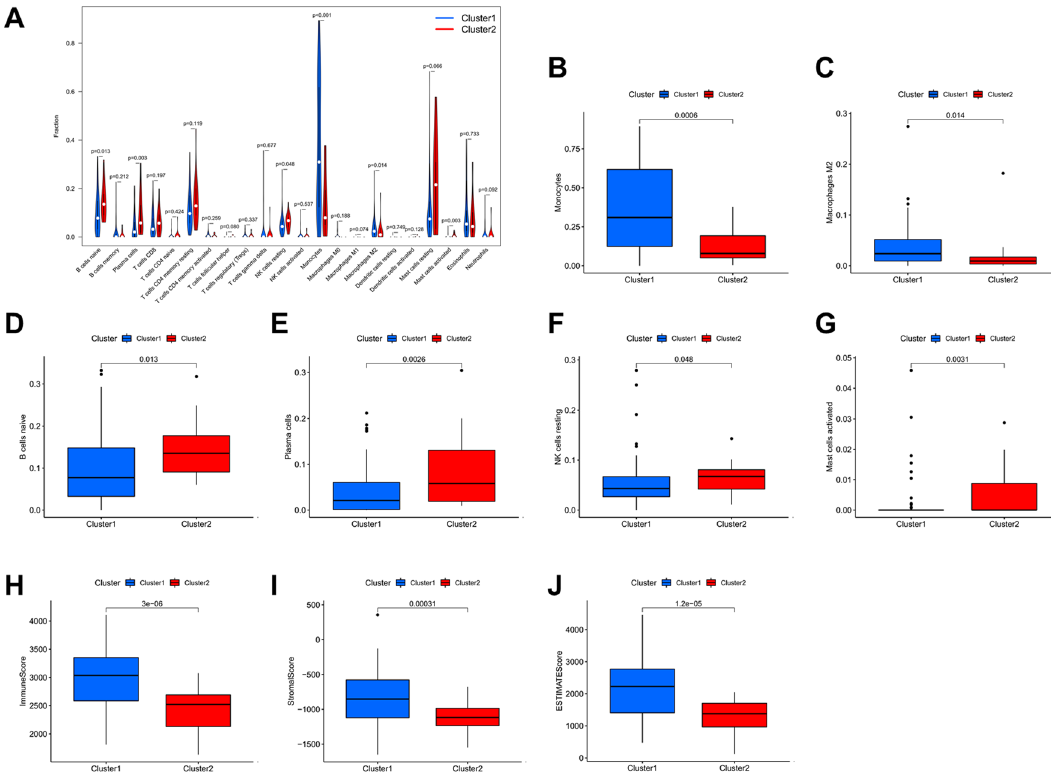
Figure 5. Characteristics of AML tumor immune microenvironment in different cluster subgroups. ( A ) A violin plot showing the ratios of 22 immune cells among clustered subgroups. ( B – G ) immune cells with different levels of expression in clustered subgroups. ( H – J ) Differences in immune, stromal, and ESTIMATE scores in different clustered